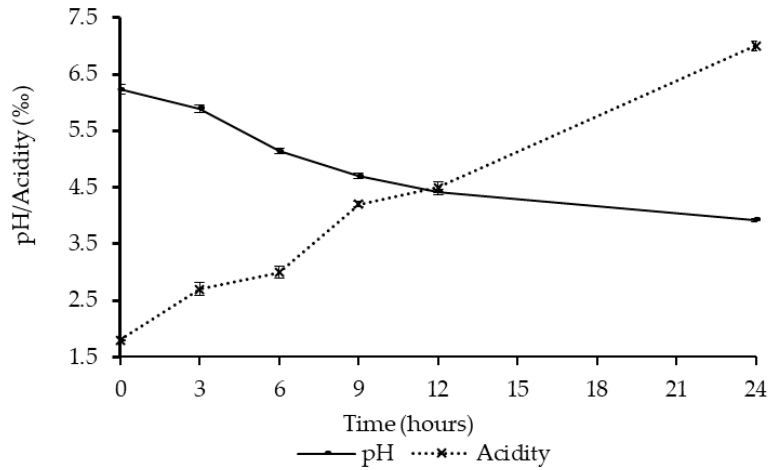
Figure 1. Changes in pH and acidity during fermentation of kwete with L. rhamnosus yoba 2012 and S. thermophilus C106 at 30 ◦ C. Data points represent means of three independent fermentations. Error bars represent standard